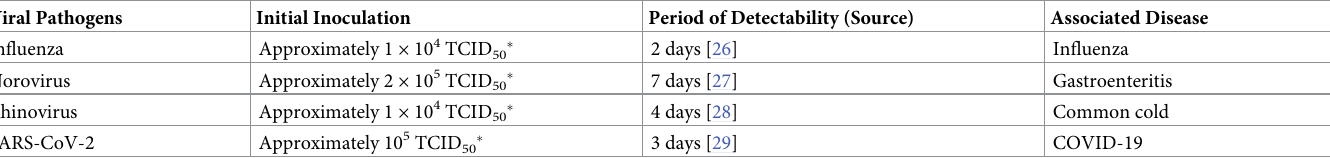
Table 2. Persistence of viral pathogens on common dry inanimate surfaces (e.g., plastics, stainless steel, or flooring). Viral Pathogens